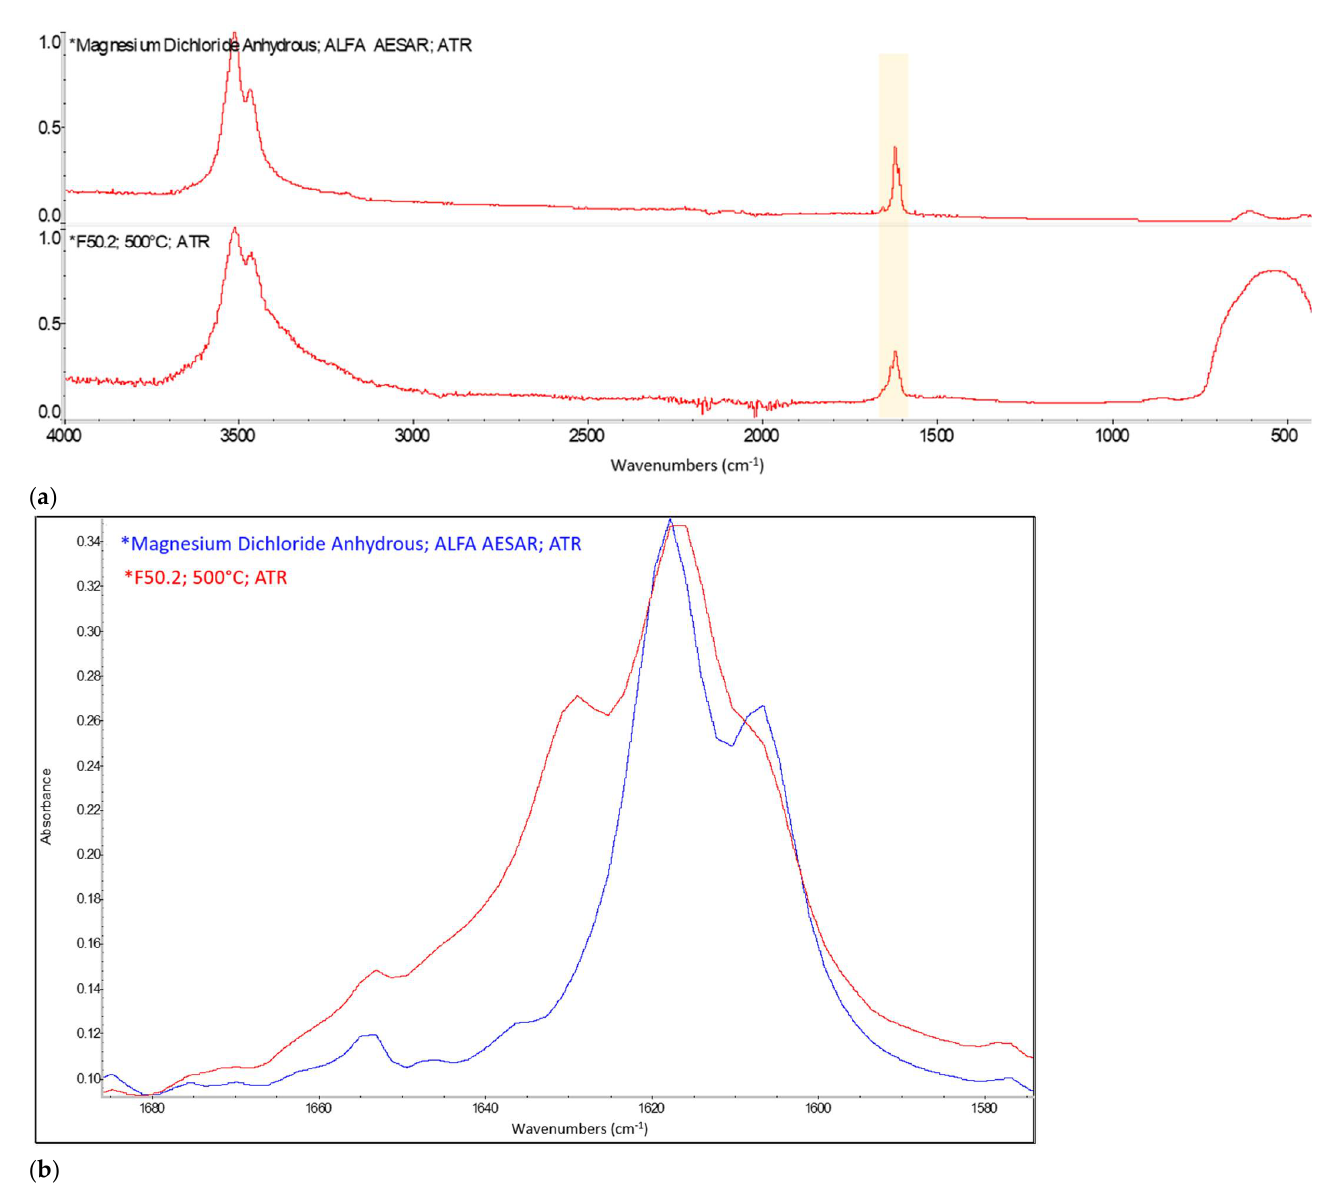
Figure A11. FTIR spectra: anhydrous MgCl 2 versus ashes of F50.2 at 500 °C. ( a ) scale 4000–400 cm −1 and ( b ) focus in the range 1660 cm −1 –1580 cm −1 , anhydrous MgCl 2 (red) and ashes of F50.2 (blue). The FTIR spectrum of the ashes matches the main bands of anhydrous MgCl 2 (1616.43 cm −1 and 1606.44 cm −1 and a minor band at 1653.26 cm −1 ). Another band is present at 1629.91 cm −1 . The different structure of the spectrum of the ashes is probably due to different hydration states of MgCl 2 .